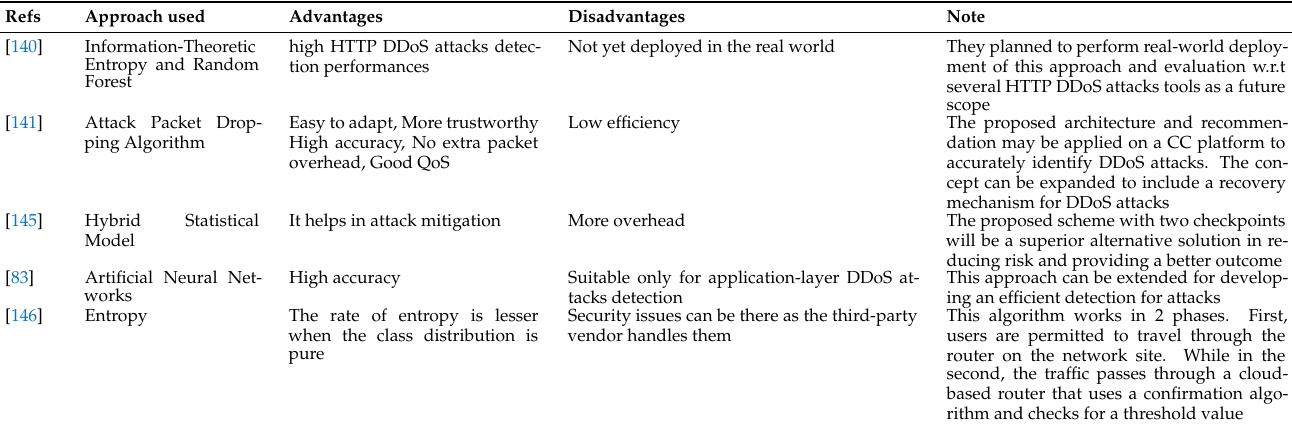
Table 15. Advantages and disadvantages of entropy